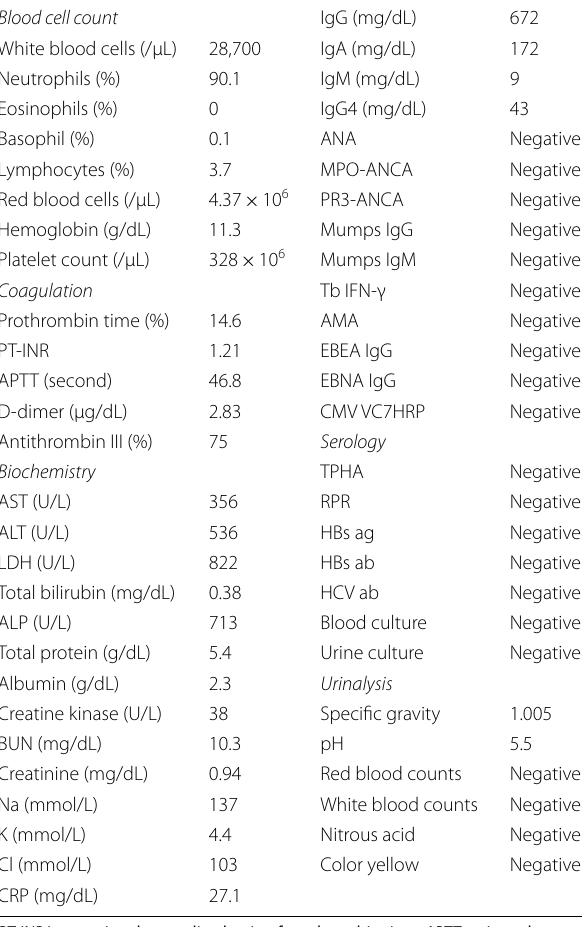
Table 2 Laboratory findings on admission